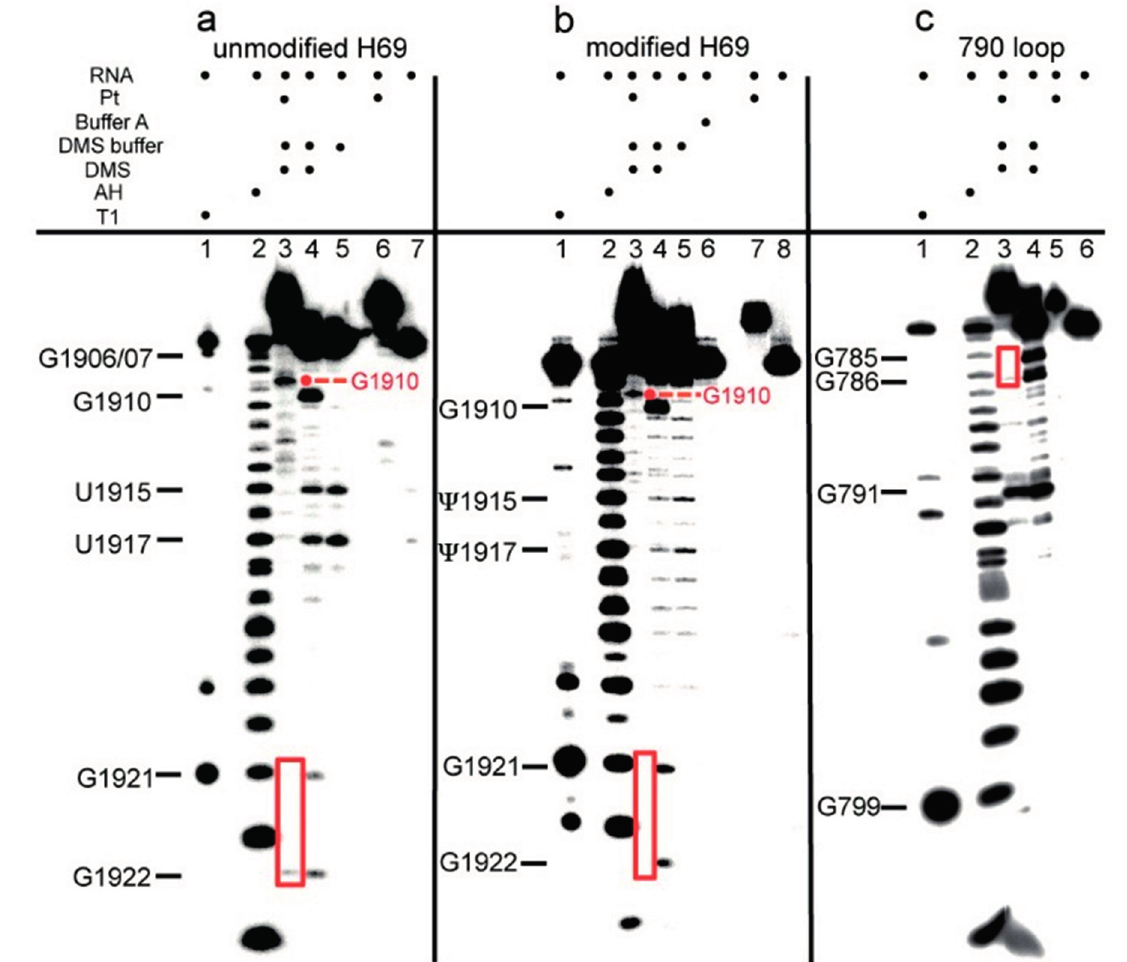
Figure 5. DMS probing of H69 and the 790 loop is shown. Autoradiograms show the results for 3 ′ -end-labeled ( a ) unmodified H69; ( b ) modified H69; and ( c ) 790 loop (T1: RNase T1 reaction on unplatinated RNA; AH: alkaline hydrolysis ladder on unplatinated RNA). Note that T1 and AH fragments migrate slower than the DMS products due to different chemical composition of the ends (5 ′ OH vs. 5 ′ phosphate, respectively). In panels a and b , the fragments corresponding to DMS reaction and cleavage at G1910 migrate more slowly in lane 3 compared to lane 4 because of the presence of the platinum adduct. Guanine residues that show slower mobility (dots) or decreased DMS reactivity (boxes) due to platination are indicated in